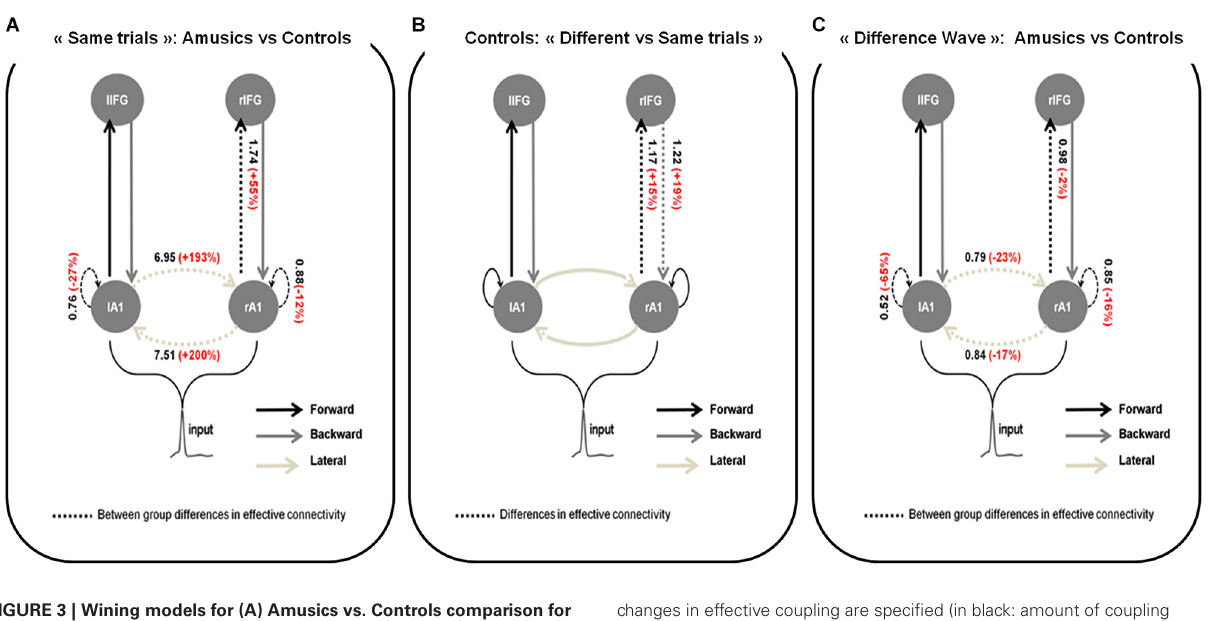
FIGURE 3 | Wining models for (A) Amusics vs. Controls comparison for “Same” trials; (B) “Different” vs. “Same” trials in S2 for controls and; (C) Amusics vs. Controls for the “Difference Wave” . Dashed arrows indicate modulated connections (i.e., connections that differ between groups (A,C) or type of trial (B) ) and solid arrows indicate fixed connections. Significant